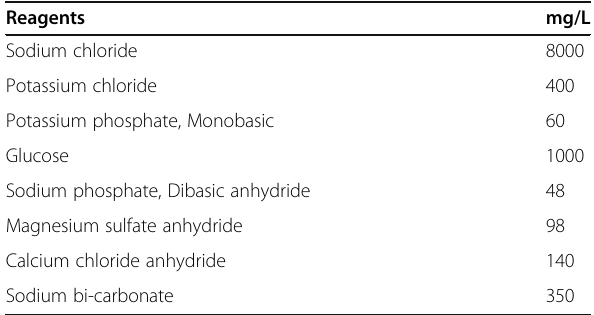
Table 1 Composition of reagents used for the preparation of buffer